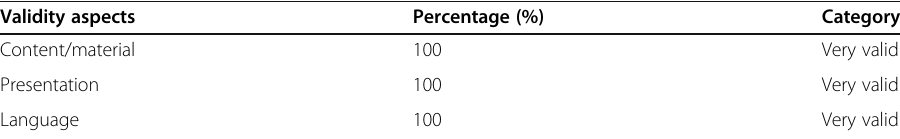
Table 2 Results of the validity test of the developed e-Book Validity